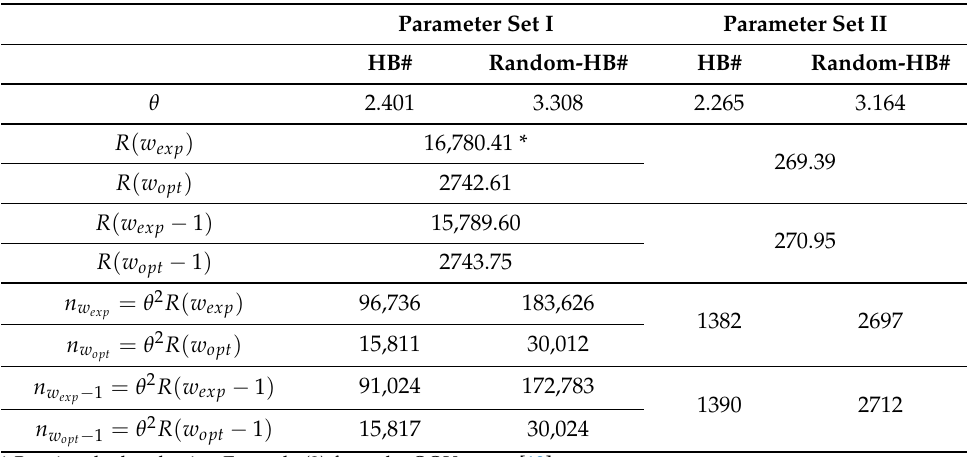
Table A1. Parameters’ values used in the OOV and PB-OOV